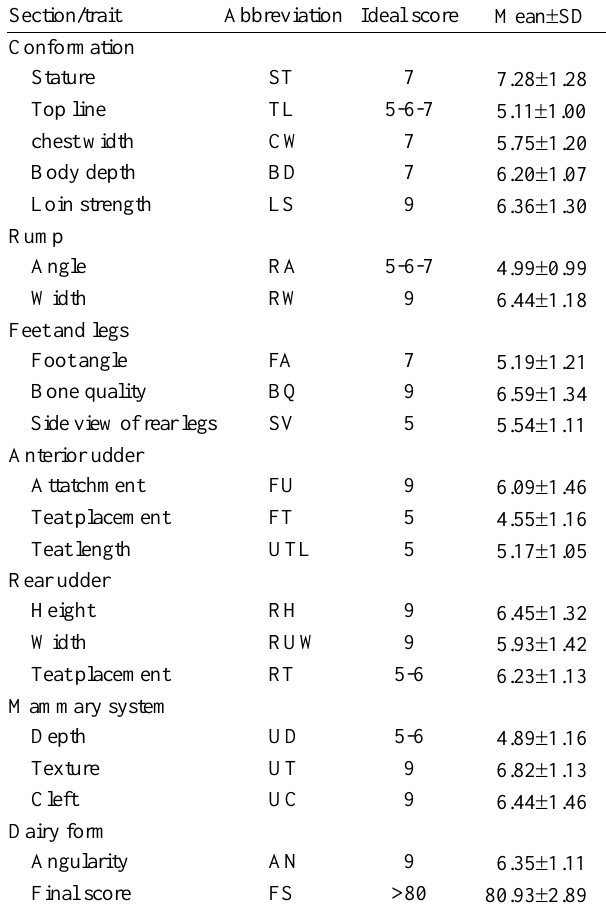
Table 1. Ideal score, mean and standard deviation (SD) for linear type traits in Brazilian Holstein cows